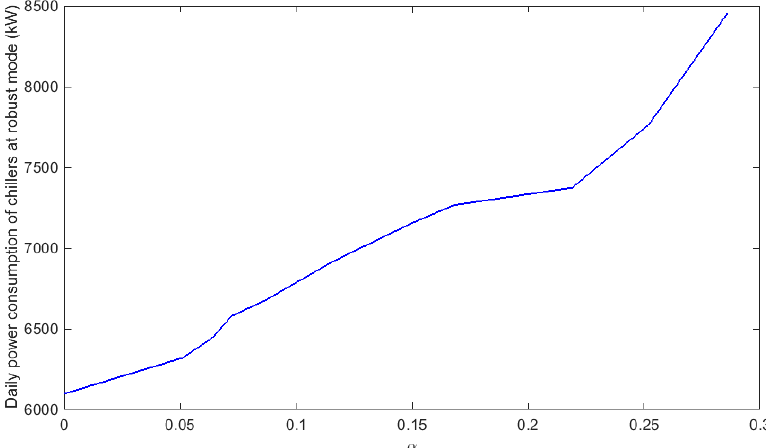
Figure 5. The minimum value of the cooling load decrease at each iteration of the opportunistic optimal chiller loading (OCL) strategy.